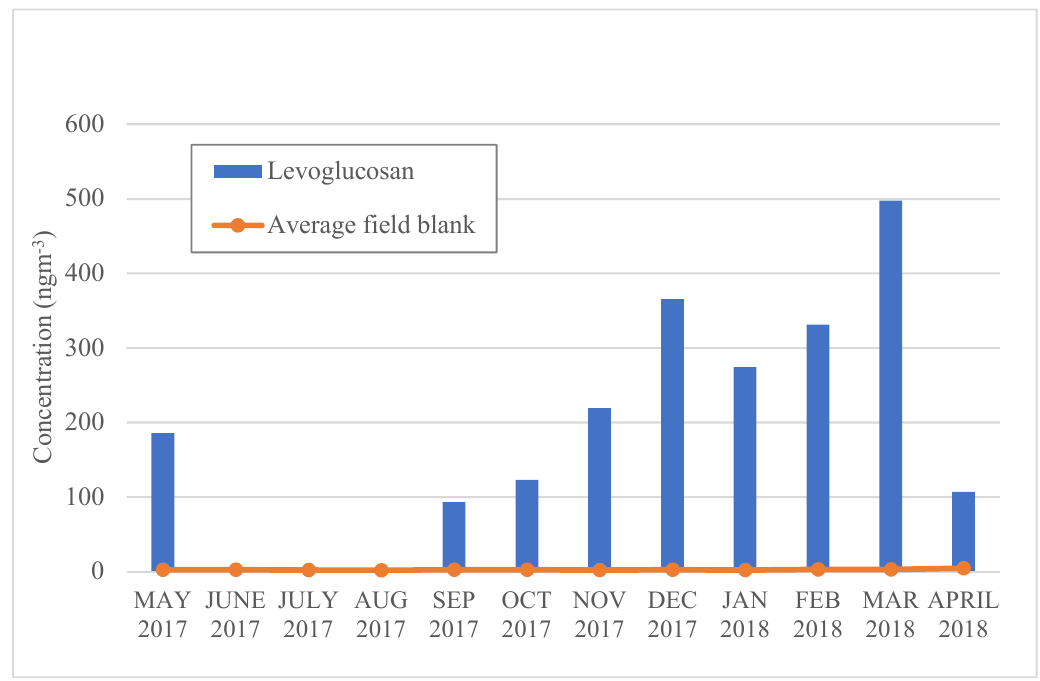
Figure 3. Monthly levoglucosan concentrations in Yangon, Myanmar.